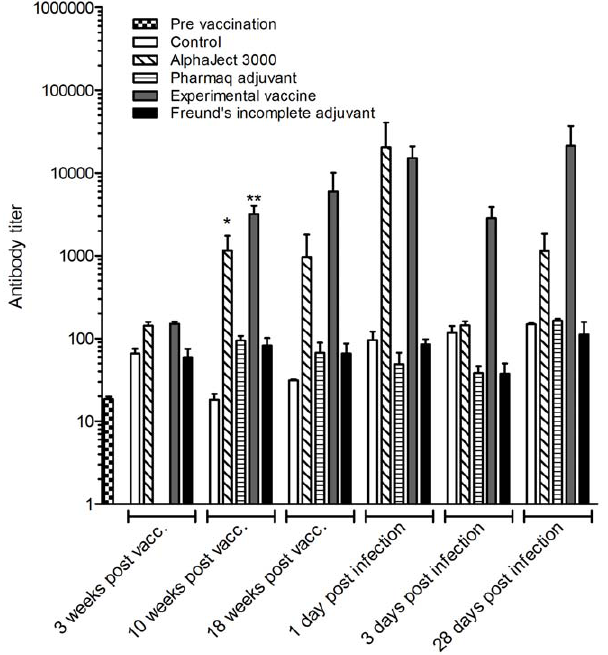
Figure 4. Correlation between antibodies and survival. Figure 3 shows a xy-plot of the survival of each group (N=30, except AlphaJect 3000 (N=28)) and the average measured absorbance in the 1:25 dilution of individual plasma samples from fish in each group (N=5). Plasma samples are taken 18 weeks post vaccination, immediately prior to bacterial challenge. The correlation was calculated using the Pearson method: P=0.046, r=0.885.